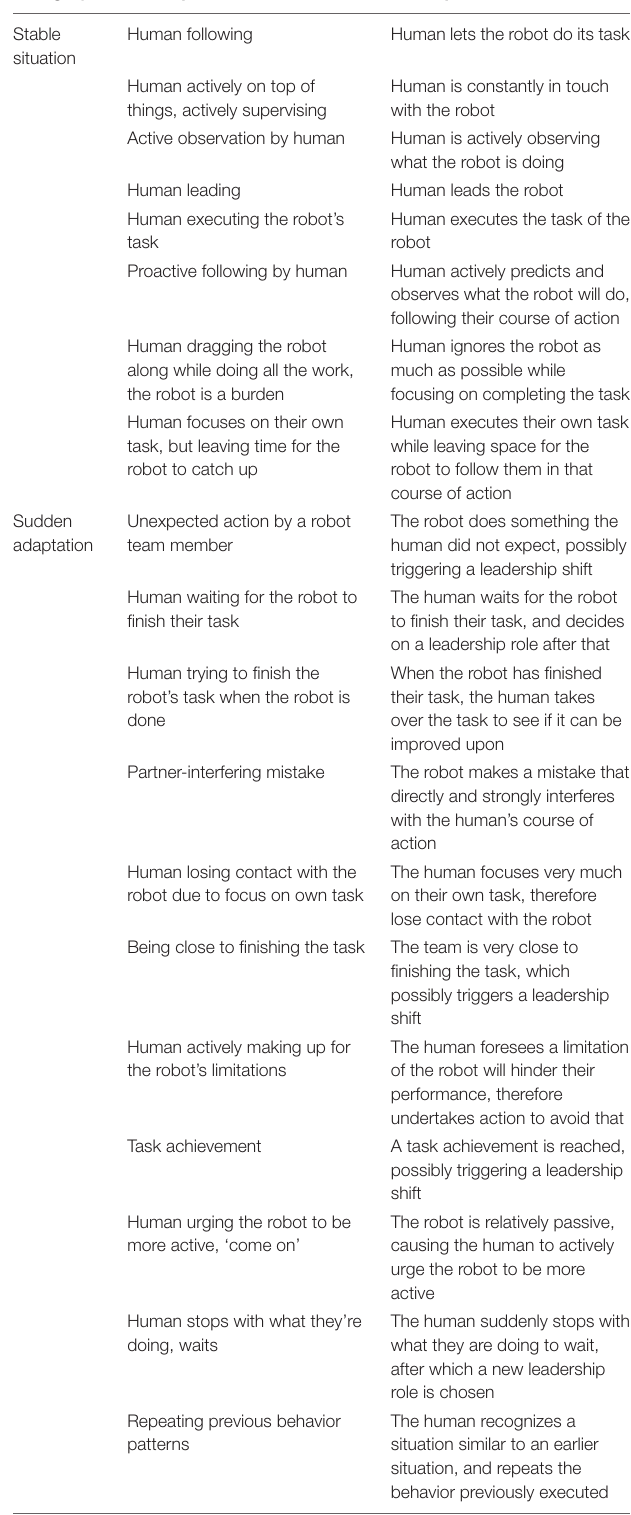
TABLE 6 | The interaction patterns identified from the behavioral data, including a description of what they